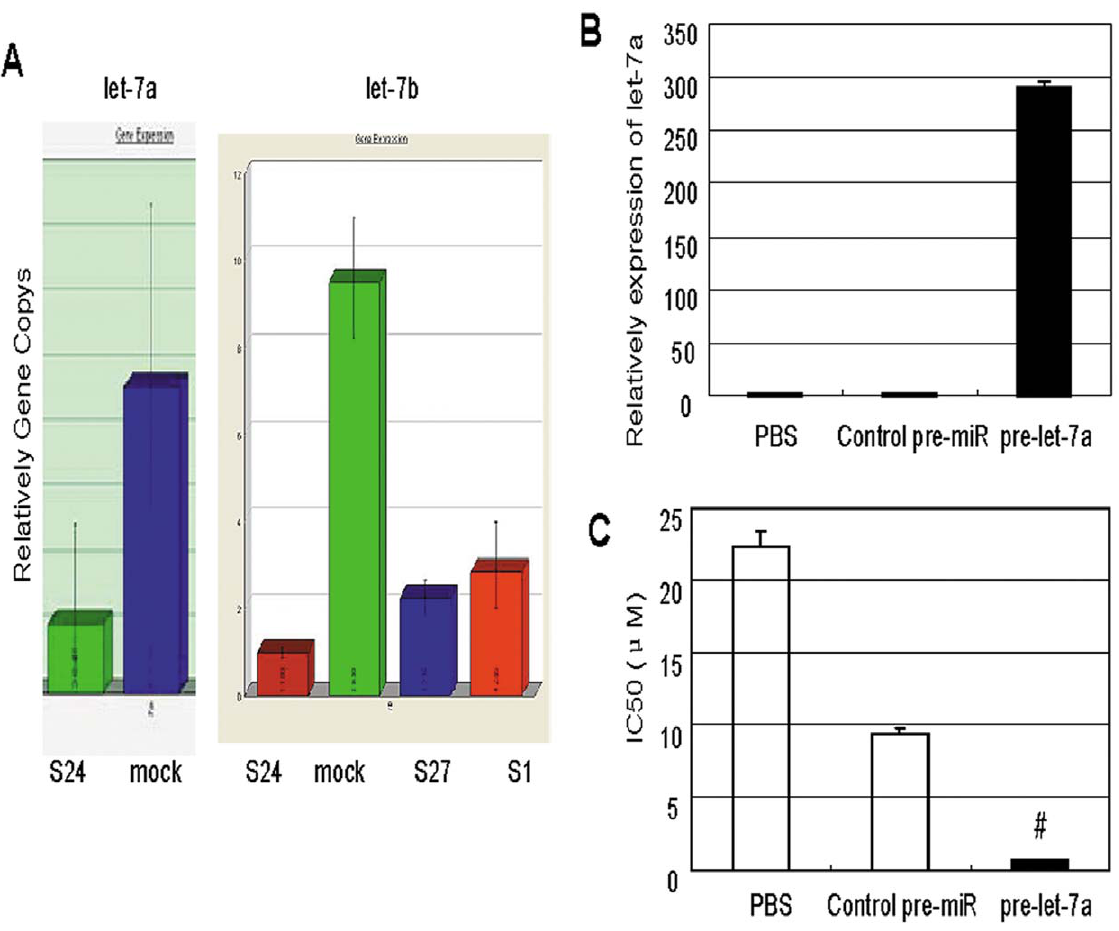
Figure 6. Lin28 downregulates Let-7 miRNA expression. (A). Expression of Let-7a or Let-7b miRNAs in SK-BR-3 cells stably expressing Lin28 was examined by qPCR. The empty vectortransfected cells were used as controls. (B). Cells were transfected with pre-Let-7a and expression of Let-7a was determined by qPCR in S1 cells stably expressing Lin28. (C). IC50 values for paclitaxel. S1 cells stably expressing Lin28 were transfected with pre- Let-7a, and cell viability and the IC50 of paclitaxel was determined by an MTT